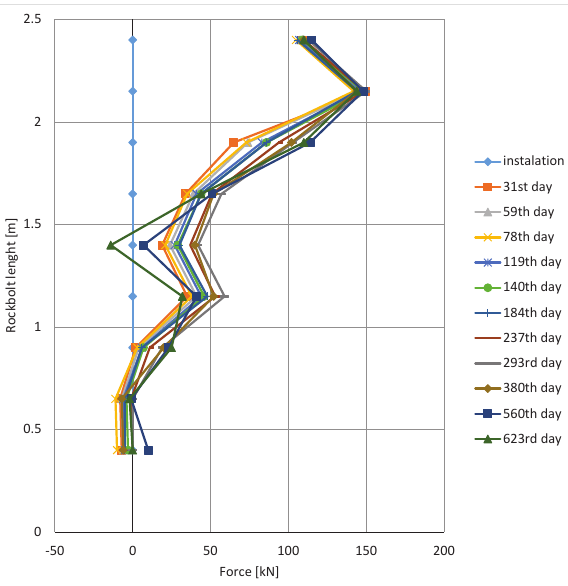
Fig. 3. Force values in the instrumented rockbolt – airway crosscut W-1 Figure 3: Force values in the instrumented rock bolt – airway cross- cut